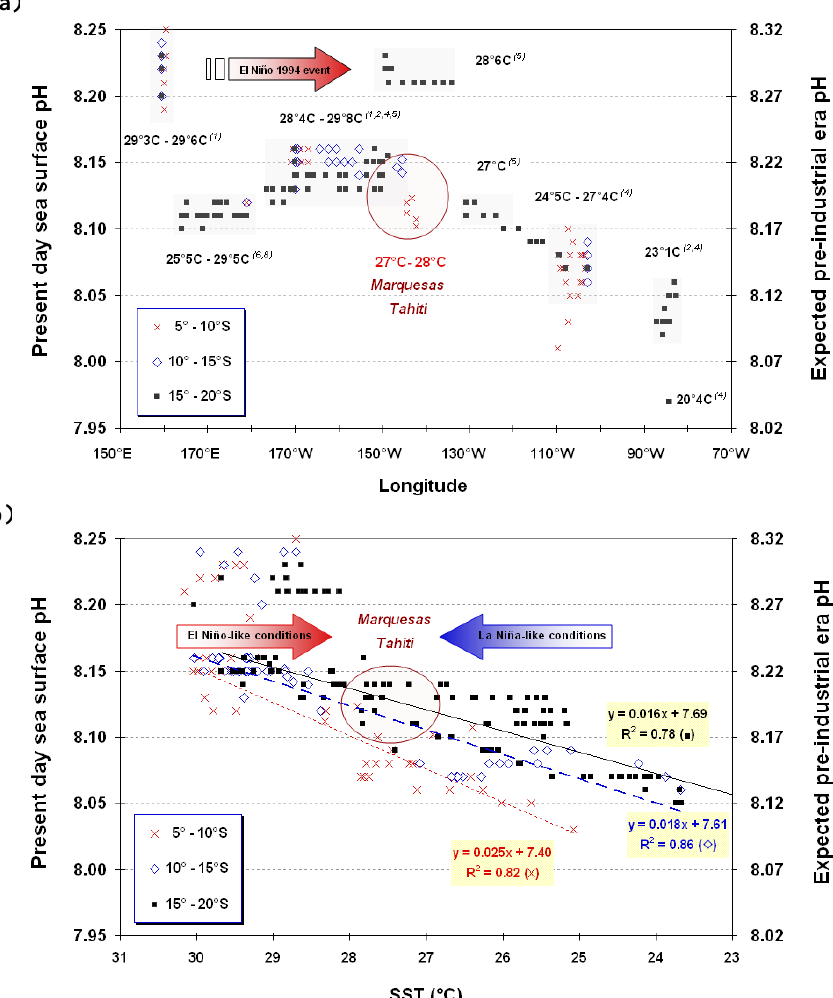
Fig. 2. (a) The present day sea surface pH in the sub-Equatorial Pacific Ocean as function of the geographical location (left axe). 0.07pH- units are added to the present day pH on the pre-industrial era pH axe (see text). The month (values in parenthesis) of the water sampling and the averaged SSTs are also indicated. (b) Sea surface pH in the sub-Equatorial Pacific Ocean plotted against SST between 150 ◦ E and 80 ◦ W. Similar pH-SST correlations were observed for surface waters between 80 ◦ W and 170 ◦ W at three different ranges of latitude (sources from http://www.nodc.noaa.gov/OC5/SELECT/dbsearch/dbsearch.html; measurement years: 1980–1998; depths: 0–50m).